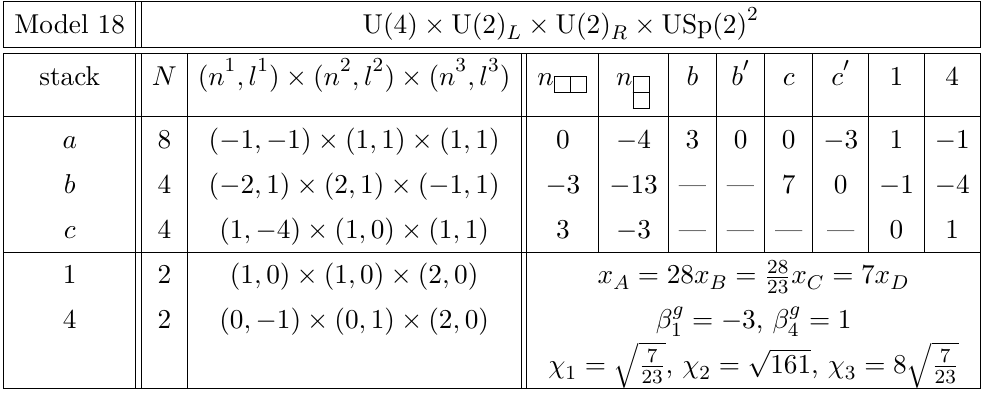
Table 25 . D6-brane configurations and intersection numbers of Model 18, and its MSSM gauge